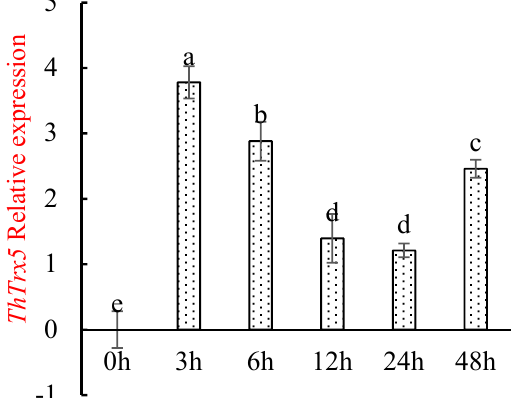
Figure 4. Relative expression of ThTrx5 gene in T. hispida under NaCl stress. Error bars show the standard deviation of T. hispida . Different lowercase letters indicate significant differences ( p ≤ 0.05 from a Student’s t test).